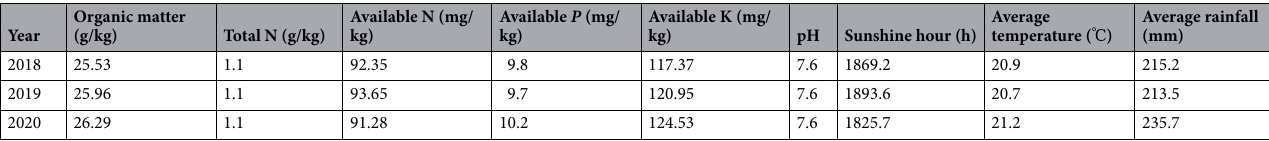
Table 1. Soil fertility and climatic